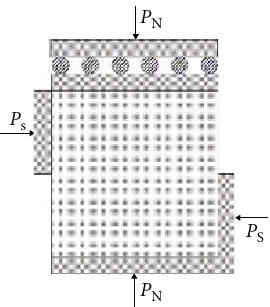
Figure 2: Force diagram of samples in a direct shear